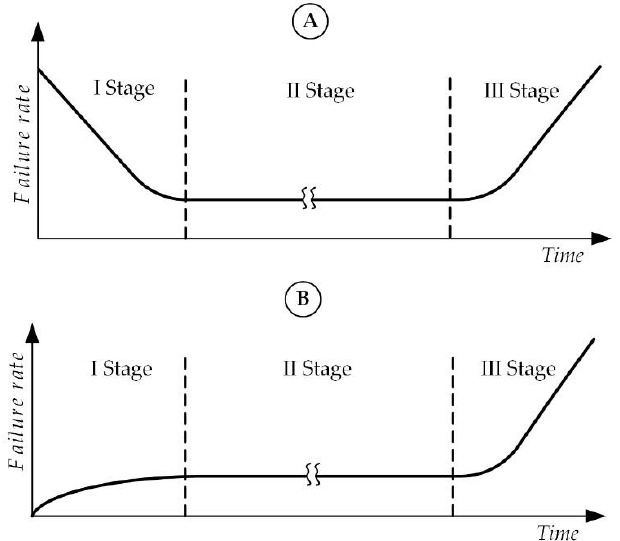
Figure 1. The failure rate in accordance with operation time; ( A )—machines manufactured in individual production; ( B )—machines manufactured in serial production